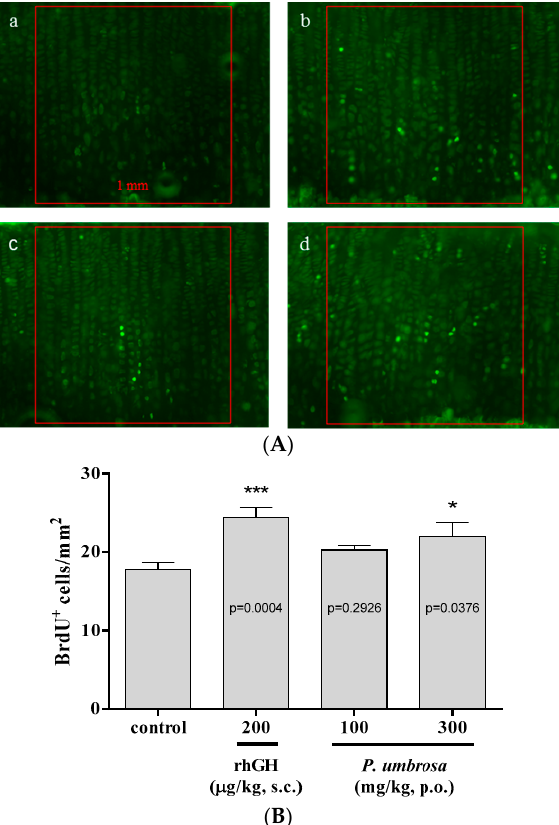
Figure 4. ( A ) Representative photomicrographs of 5-bromo-2 ′ -deoxyuridine (BrdU)-labeled chondrocytes of the proximal tibial growth plate, Green: BrdU-labeled chondrocyte, ( a ) vehicle treated control group; ( b ) rhGH 200 μ g/kg (s.c.) treated group; ( c ) P. umbrosa 100 mg/kg (p.o.) treated group; ( d ) P. umbrosa 300 mg/kg (p.o.) treated group. Each box area is 1 mm 2 ; ( B ) Effects of P. umbrosa on chondrocyte proliferation of proximal tibial growth plate in female adolescent rats. Each value is the mean ± SD. The number of animals is four per group; * p < 0.05 and *** p < 0.001 vs. control (one-way ANOVA, Bonferroni